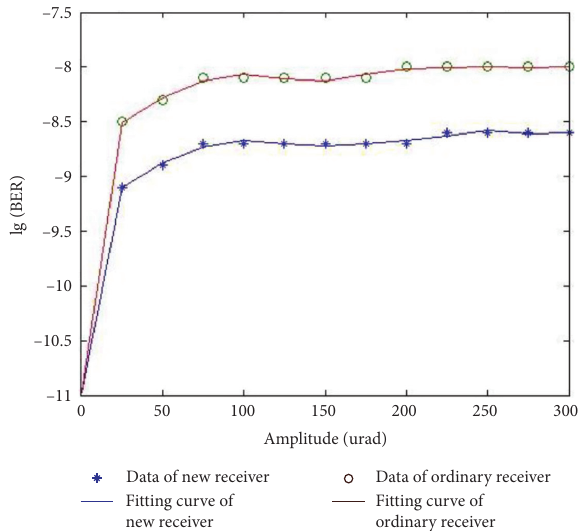
Figure 8: lg(BER) of both new and ordinary receivers (frequency: